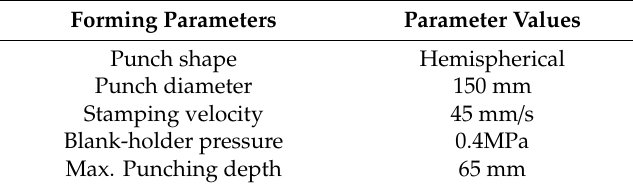
Figure 5. Formability process of the sample by the hemispherical punch ( a ) before forming and ( b ) while forming. Table 2. The di ff erent forming parameter used during formability